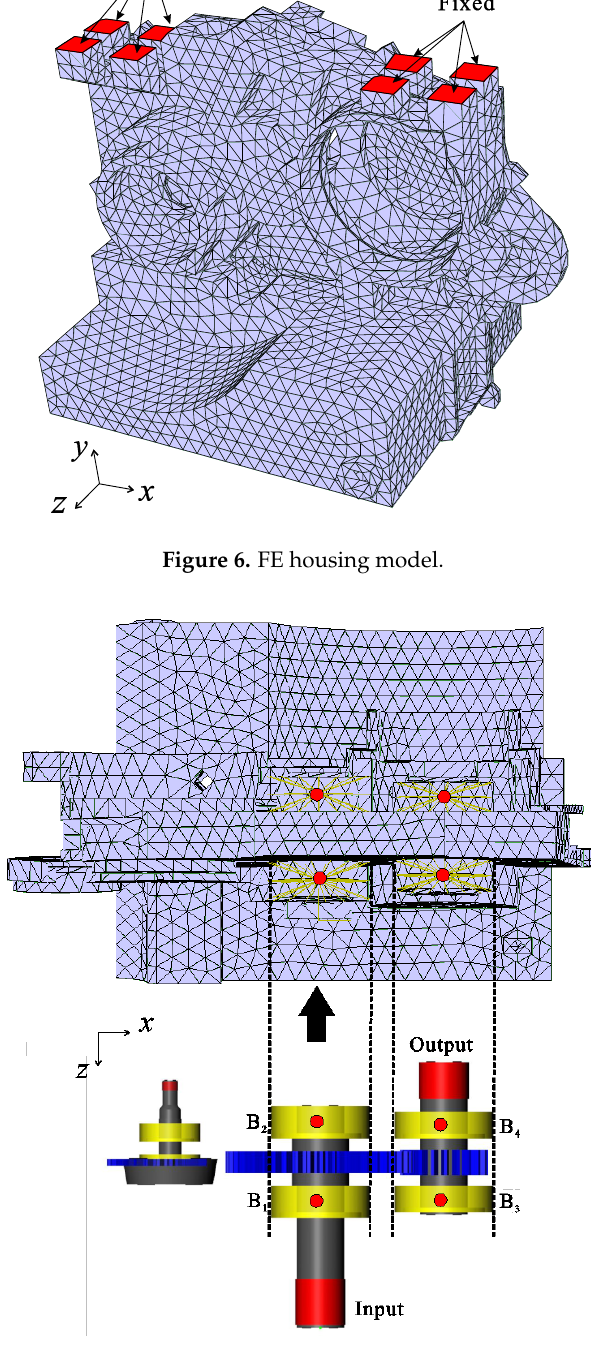
Figure 7. Placement of gear assembly in FE housing. Table 1. Material properties of housing.